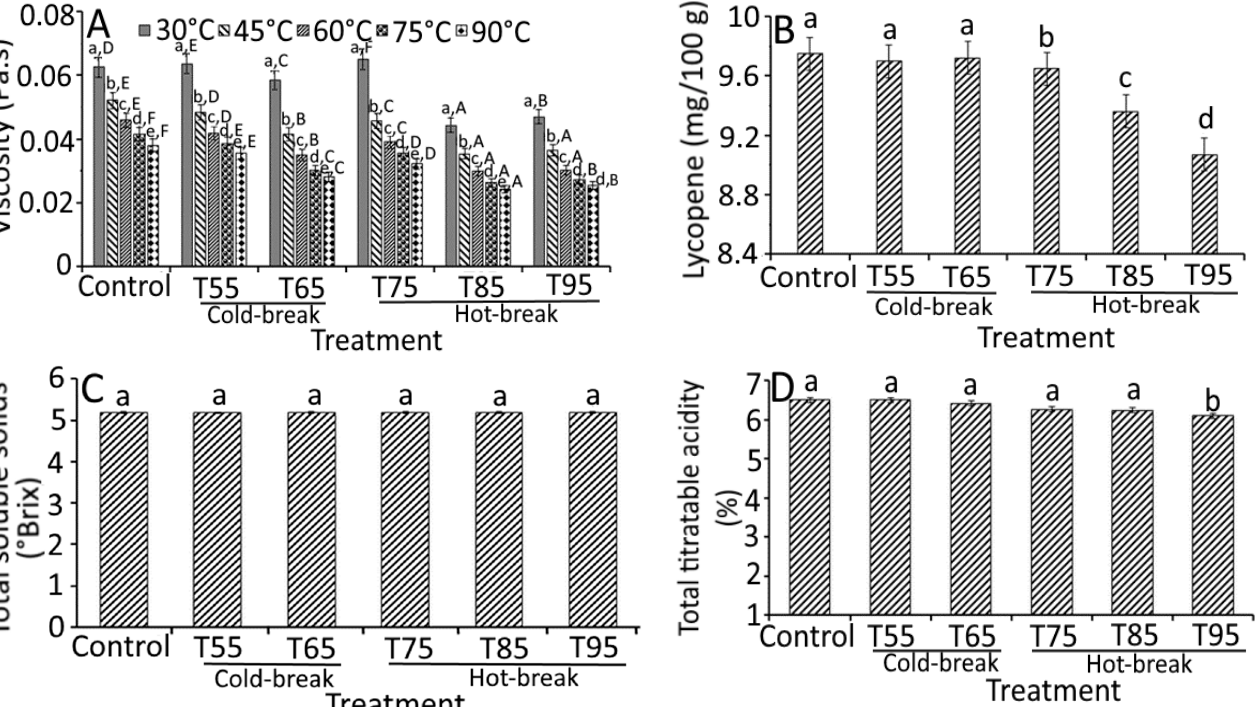
Figure 4. Effect of heat treatments on the quality characteristics of currant tomato pulp. Apparent viscosity ( A ), lycopene ( B ), total soluble solids ( C ), and total titratable acidity ( D ). The error bar represents the standard deviation from the mean of independent triplicate results. Different lowercase letters (a–e) within the treatment indicate a significant difference ( p < 0.05) based on Duncan’s multiple range test. In Figure 4A, different uppercase letters (A–F) among the holding temperatures indicate a significant difference ( p < 0.05) based on Duncan’s multiple range test. T55 and T95 represent coded temperature values for cold- and hot-break heat treatments.